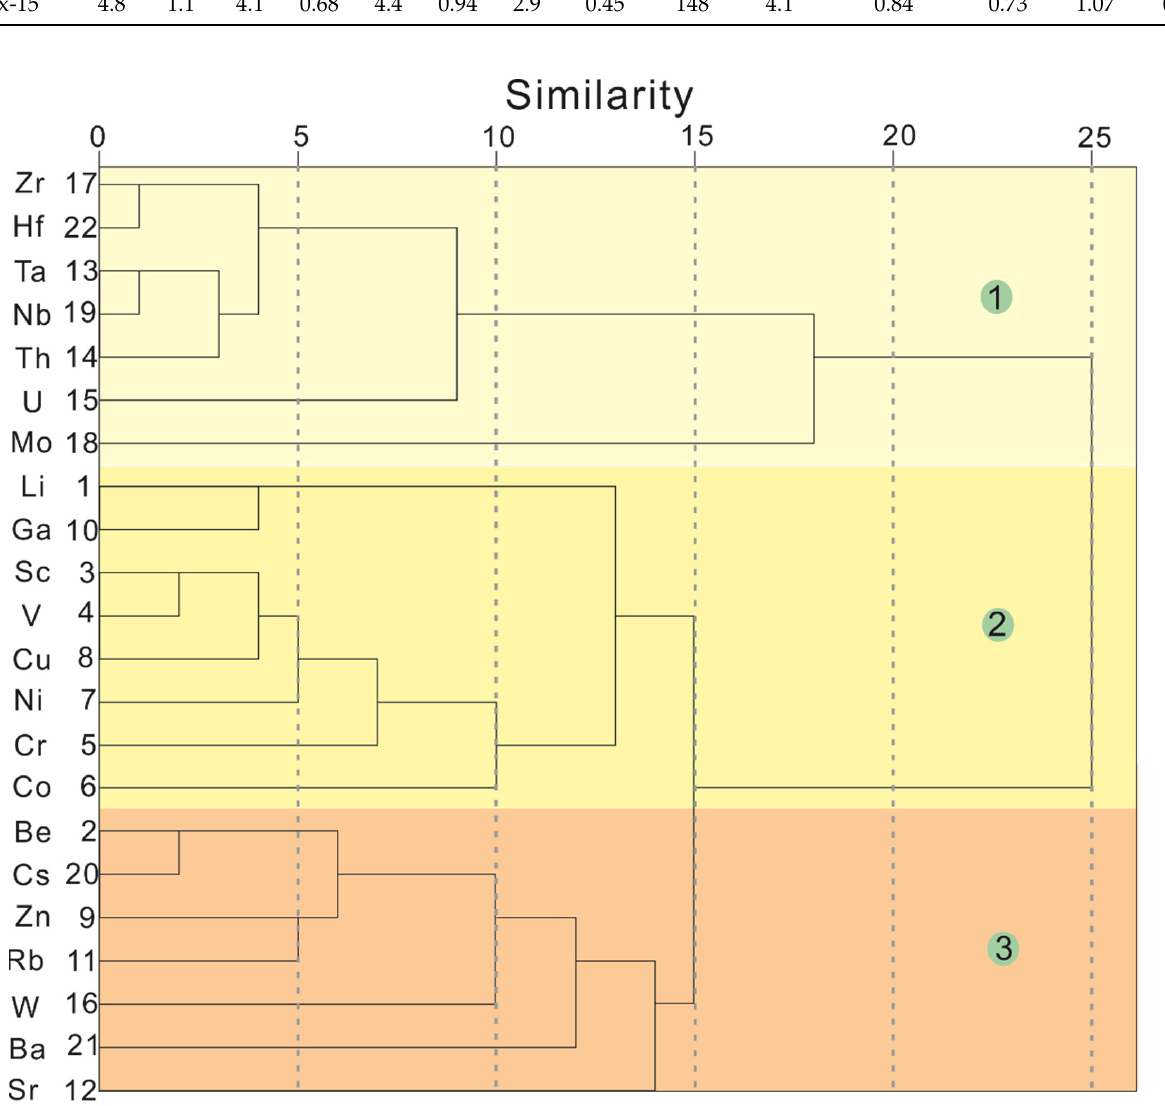
Figure 3. Cluster analysis of trace elements. The labeled categories are discussed in the text. Category (a) is mainly high-field-strength elements, including Zr, Th, Hf, Ta, and Nb, indicating the influence of terrigenous matter [52,53]. Category (b) includes Li, Ga, Sc, V, Cu, Co, and Cr, and Category (c) includes Ba, Sr, Rb, Zn, W, Cs, and